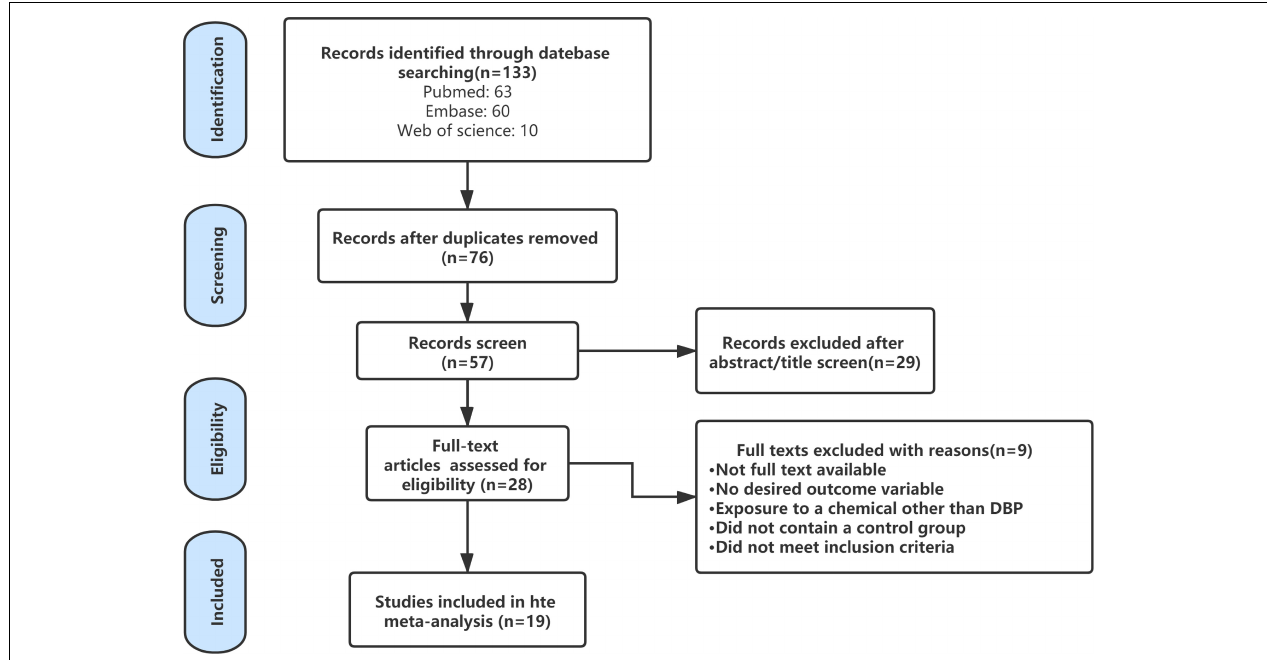
FIGURE 1 | Flow diagram of literature search and selection